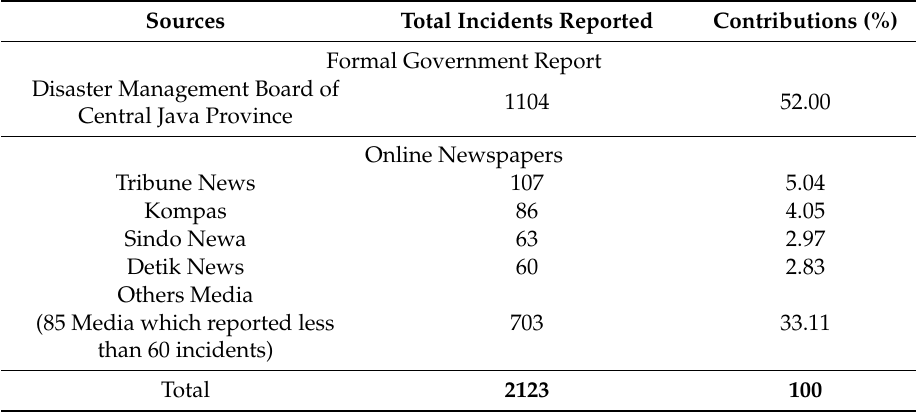
Table 4. Largest Contribution of Flood Data